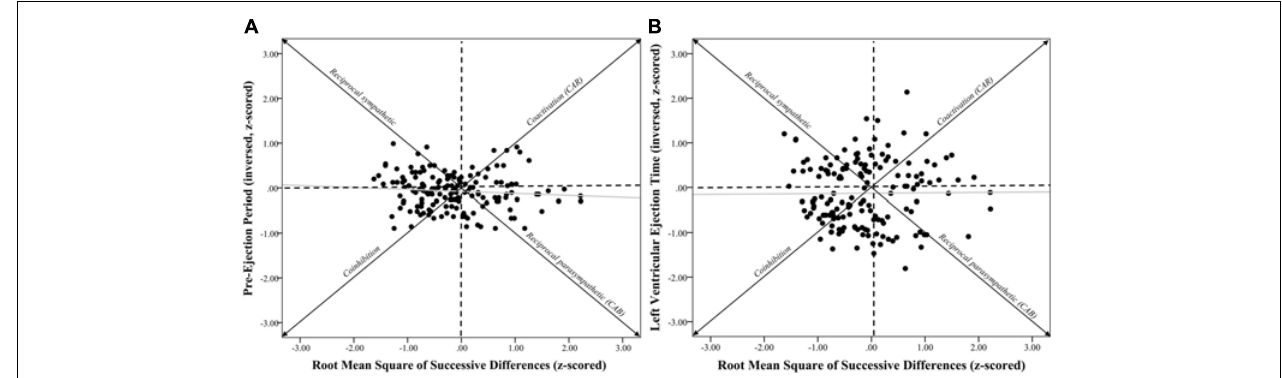
FIGURE 2 | Systolic time intervals and root mean square of successive differences scatterplots. Note . ( A ) shows a scatterplot between pre-ejection periods (PEP z -scored and inversed, see section “METHODS” for details) and root mean square of successive differences (RMSSD-HRV, z -scored) ( r = –0.09, p = 0.28). ( B ) shows a scatterplot between left ventricular ejection time (LVET inversed and z-scored) and RMSSD-HRV ( r = 0.01, p = 0.91). Individuals in the coinhibition quadrant would show lower CAR scores, while individuals in the coactivation quadrant would show higher CAR scores. Individuals in the reciprocal sympathetic quadrant would show lower CAB scores, while individuals in the reciprocal parasympathetic quadrant would show higher CAB scores.